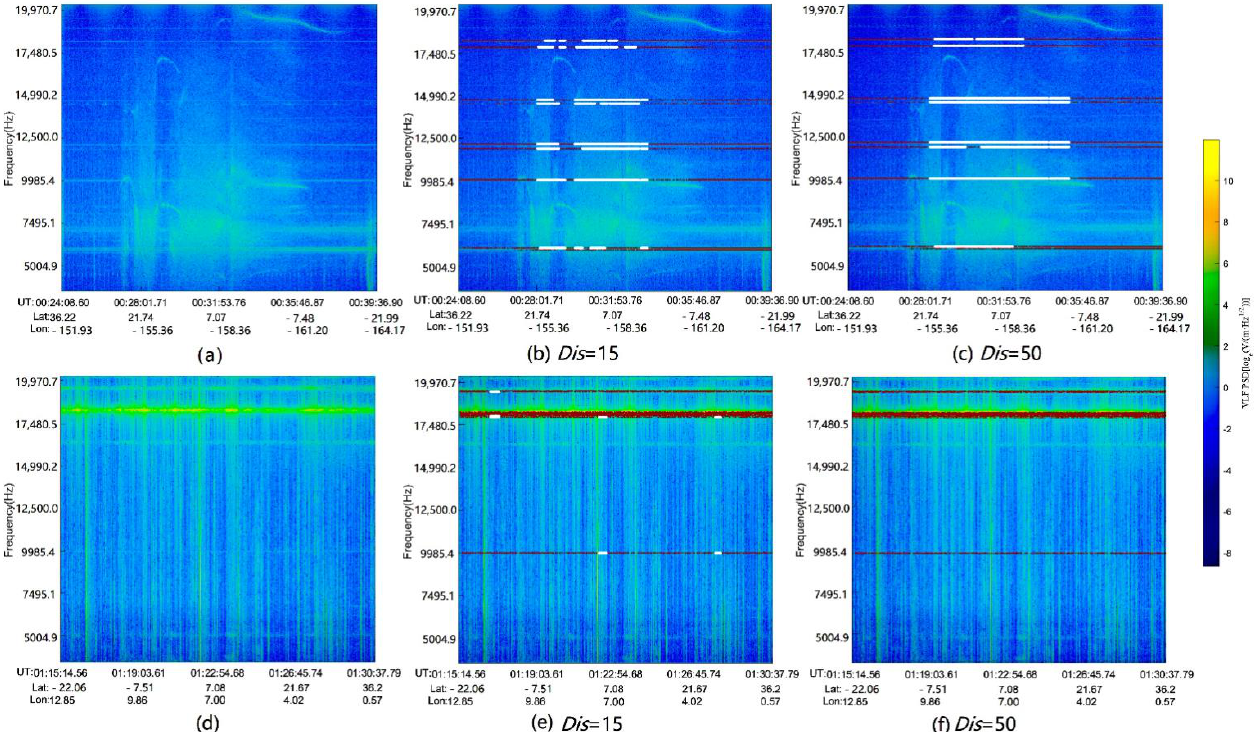
Figure 10. Comparison of spectrograms detection effects of different features.